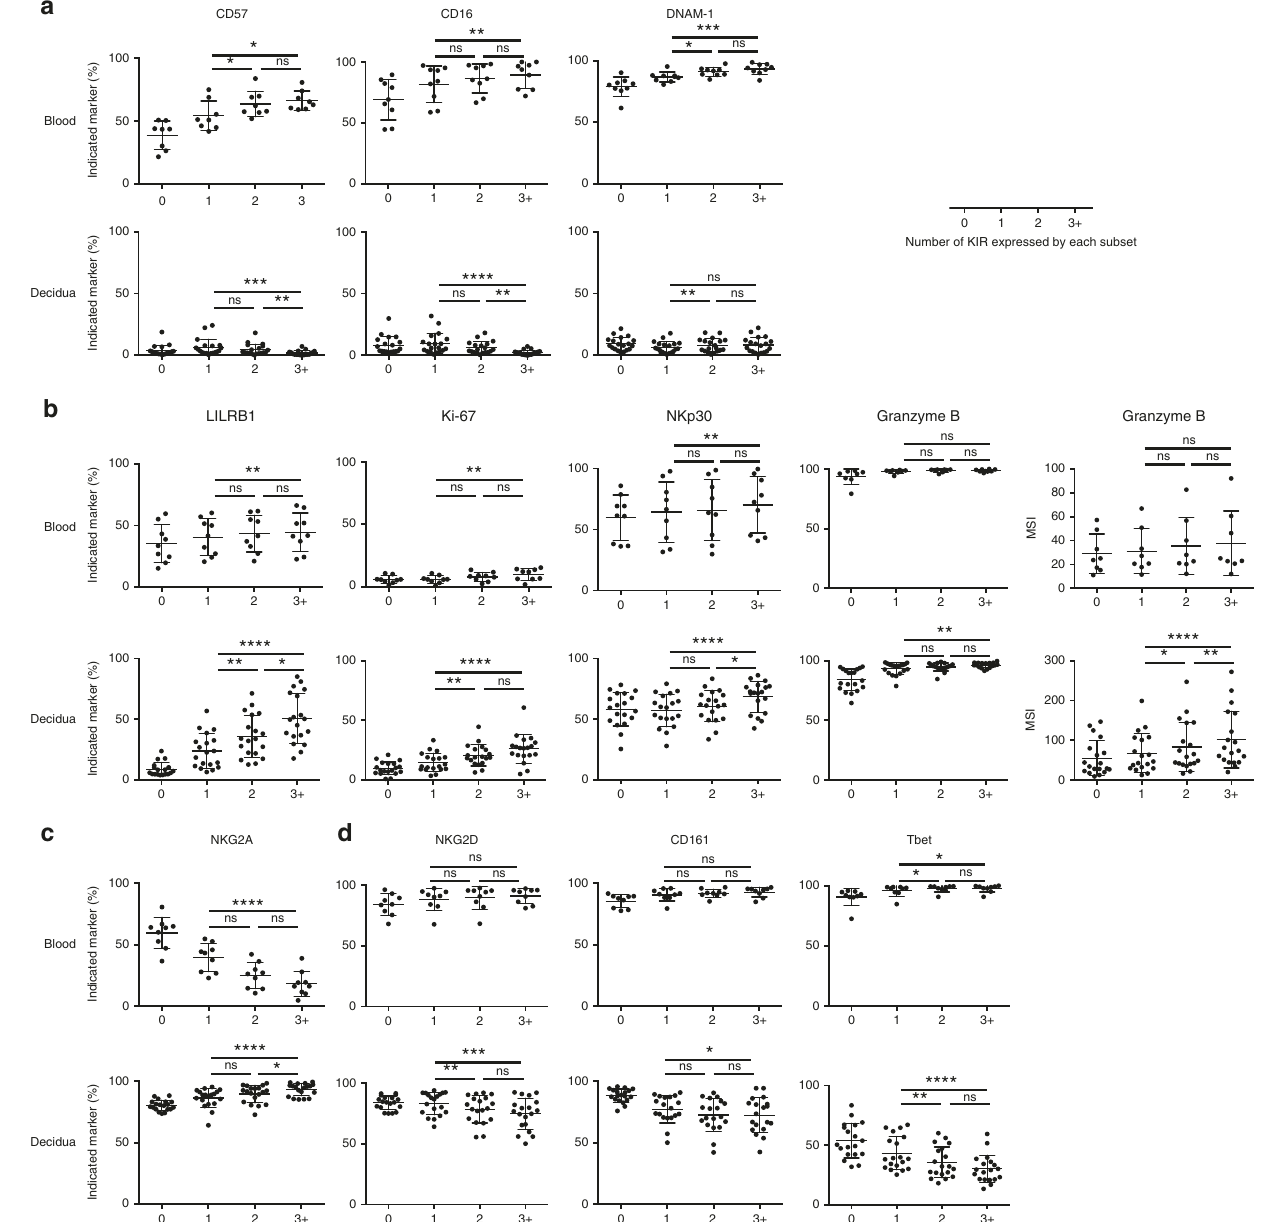
Fig. 4 KIR acquisition on dNK and pbNK. Boolean combinations of KIR receptors were gated manually on Lineage negative (Lin − ) CD56 + dMCs and Lin − CD56dim PBMCs following mass cytometry and grouped according to the number of KIR expressed from zero to three or more KIR (3 + ). Markers are grouped in the following way a increase on CD56dim pbNK, b increase on dNK, c decrease on CD56dim pbNK, d decrease on dNK ( n = 19 decidua and 8 – 9 peripheral blood, fi ve pregnant and four non-pregnant blood donors). Friedman tests using Dunn ’ s correction for multiple testing were performed for KIR = 1, 2, 3 + . Error bars represent SD. * p < 0.05, ** p < 0.01, *** p < 0.001, **** p < 0001. Source data are provided as a Source Data fi